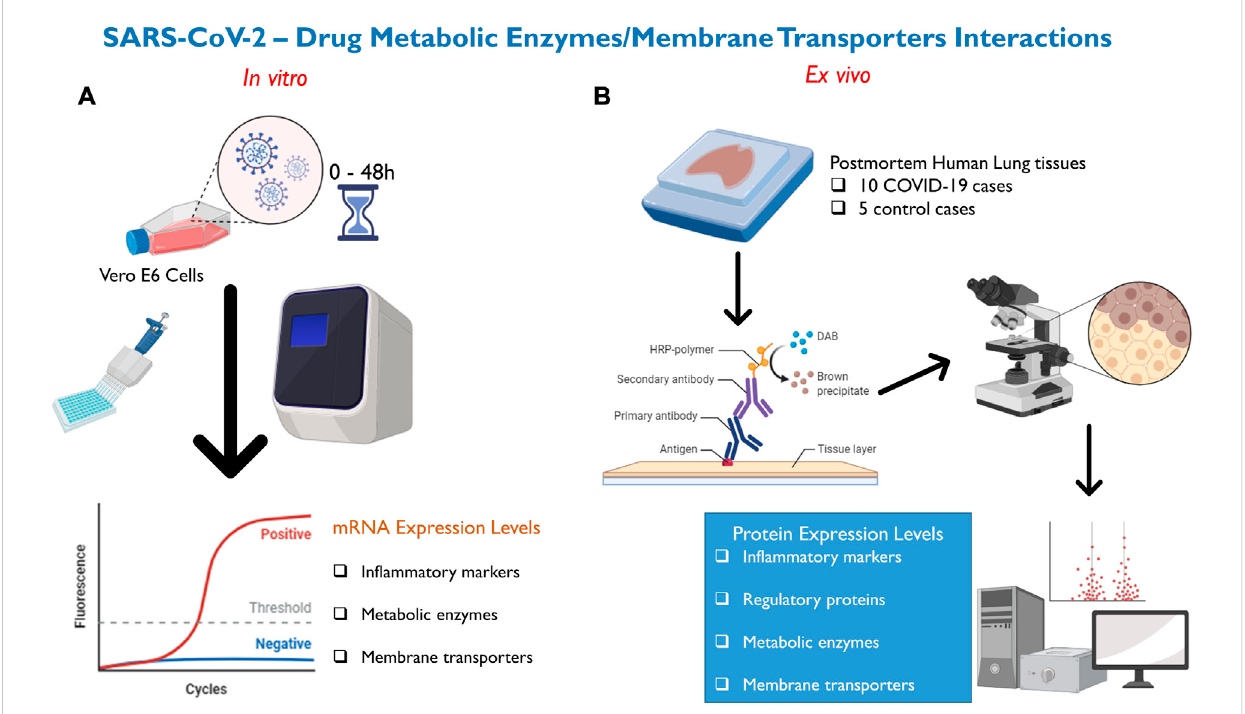
FIGURE 1 Methods deployed for investigation of SARS-CoV-2 — DMETs interactions. (A) Vero E6 cells were infected with SARS-CoV-2 virus and cell pellets were collected at 0-, 6-, 24-,and 48- hours post-infection. Subsequently, relative mRNA expressionof selected clinically relevant in fl ammatory markers (9), DMETs (12) was determined using qRT-PCR. (B) Chromogenic immunohistochemistry was used to localize and compare changes in protein expression of clinically relevant in fl ammatory markers (2), xenosensing regulatory proteins (4), DMETs (13) between COVID-19 and control postmortem human lung